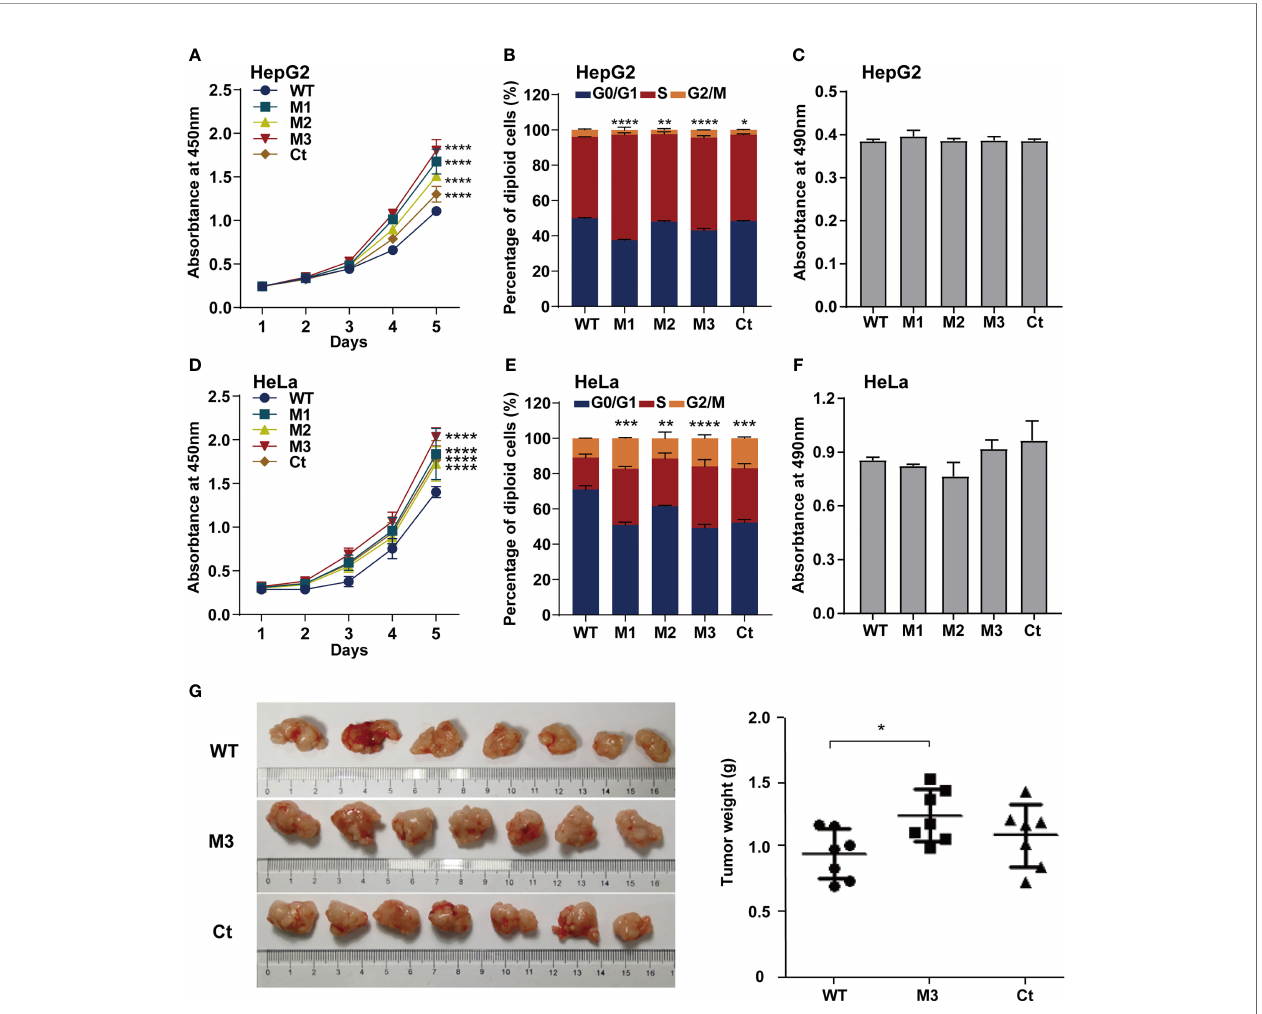
FIGURE 4 | Effects of HBx mutations on malignant phenotypes of cancer cells. (A) CCK8 assays showed that ectopic expression of the HBx mutants signi fi cantly increased the proliferation of HepG2 cells, compared to WT-HBx. (B) Flow cytometry assays showed that the rate of cells in S phase was signi fi cantly higher in HepG2 cells expressing HBx mutants than in those expressing WT-HBx. (C) Transwell assays showed that ectopic expression of the HBx mutants had no signi fi cant effect on the migration of HepG2 cells, compared to WT-HBx. (D) CCK8 assays showed that ectopic expression of the HBx mutants signi fi cantly increased the proliferation of HeLa cells, compared to WT-HBx. (E) Flow cytometry assays showed that the rate of cells in S phase was signi fi cantly higher in HeLa cells expressing HBx mutants than in those expressing WT-HBx. (F) Transwell assays showed that ectopic expression of the HBx mutants had no signi fi cant effect on the migration of HeLa cells, compared to WT-HBx. (G) Tumor weights among different groups. * P < 0.05; ** P < 0.01; *** P < 0.001; **** P <